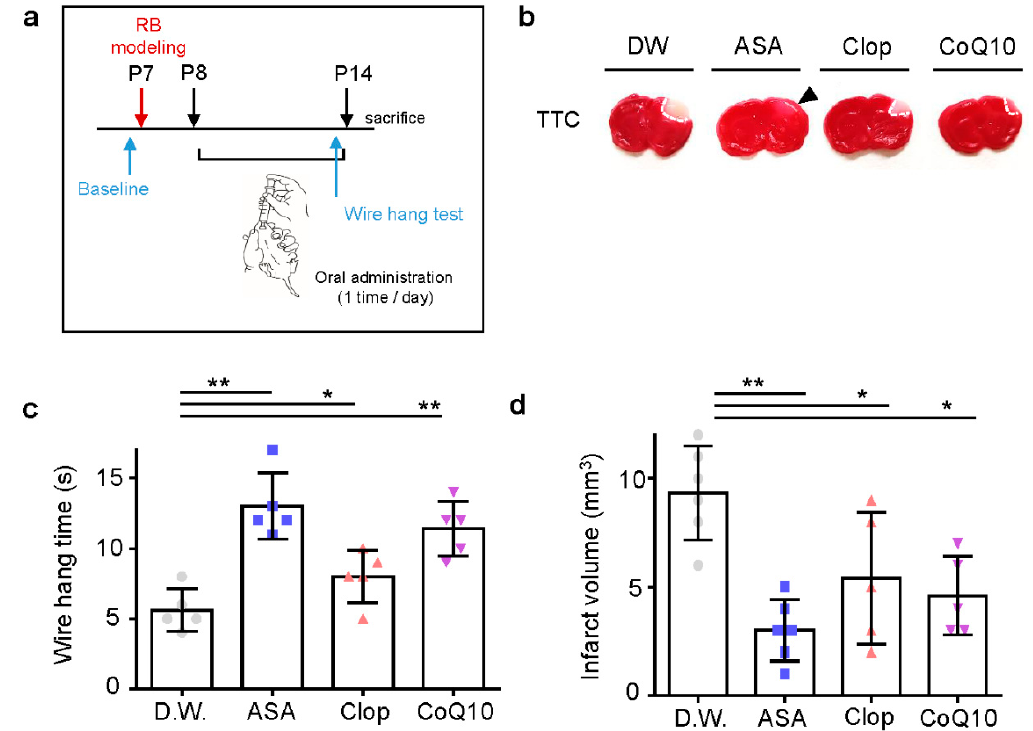
Figure 5. Neuroprotective effects of drugs post-treatment on the infarct volume and behavioral function in a neonatal rat model of photothrombotic stroke. ( a ) Experimental design for drugs by oral administration and RB animal modeling. ( b ) Representative images of coronal brain sections stained with TTC. ( c ) The length of time until the rat fell from the wire was recorded at perinatal day 14 after RB photothrombosis and after drug treatment for seven days. ( d ) Brain infarct volumes in rats after 24 h are presented as mean ± SD. ** p < 0.005; * p < 0.01 compared with the D.W. group.